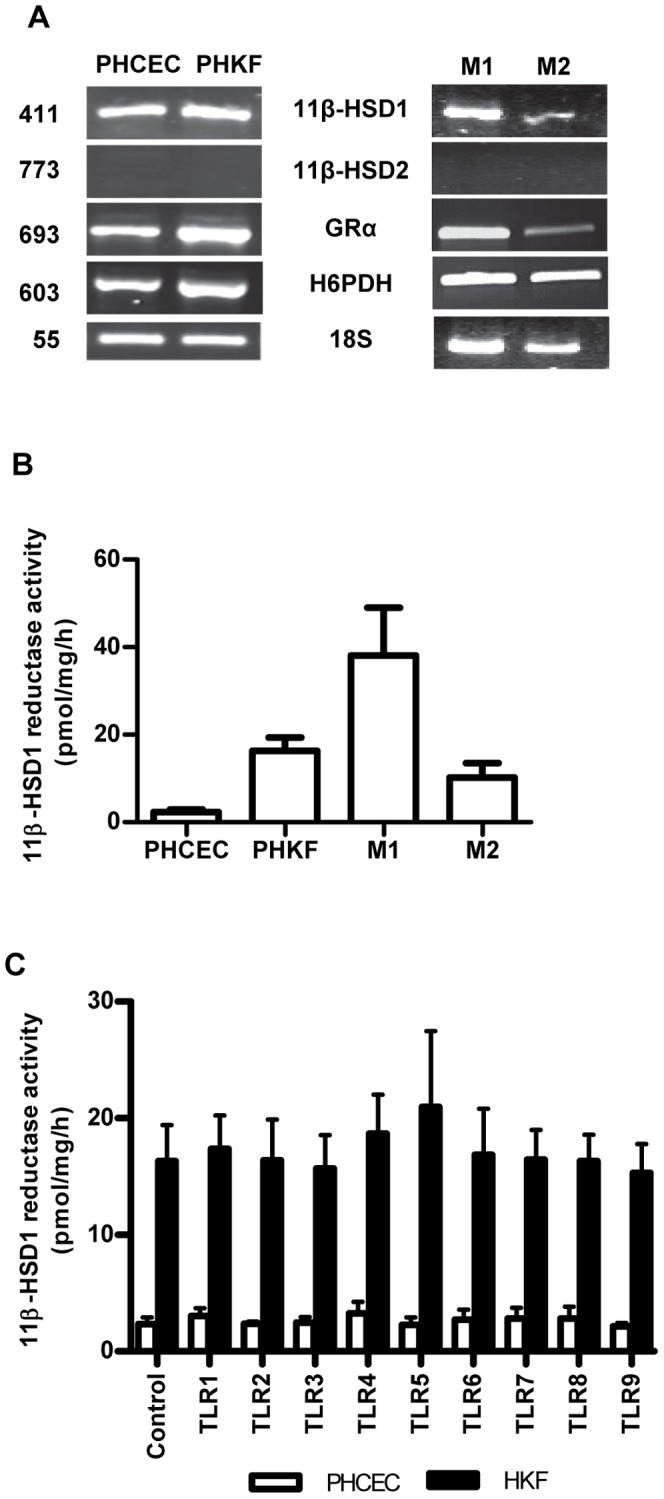
Pre-receptor regulation of glucocorticoids and TLR expression in human corneal cells.(A) RT-PCR of PHCEC, PHKF showing expression of the major genes for the pre-receptor regulation of glucocorticoids: 11β-HSD1, 11β-HSD2, H6PD and GR. Macrophages, M1 and M2, also express 11β-HSD1 but not 11β-HSD2. All cell types demonstrate 11β-HSD1 oxo-reductase activity (B), most marked in M1 macrophages. (C) TLR 1–9 induction did not alter 11β-HSD1 activity in either PHCEC or PHKF after stimulation for 16 h.